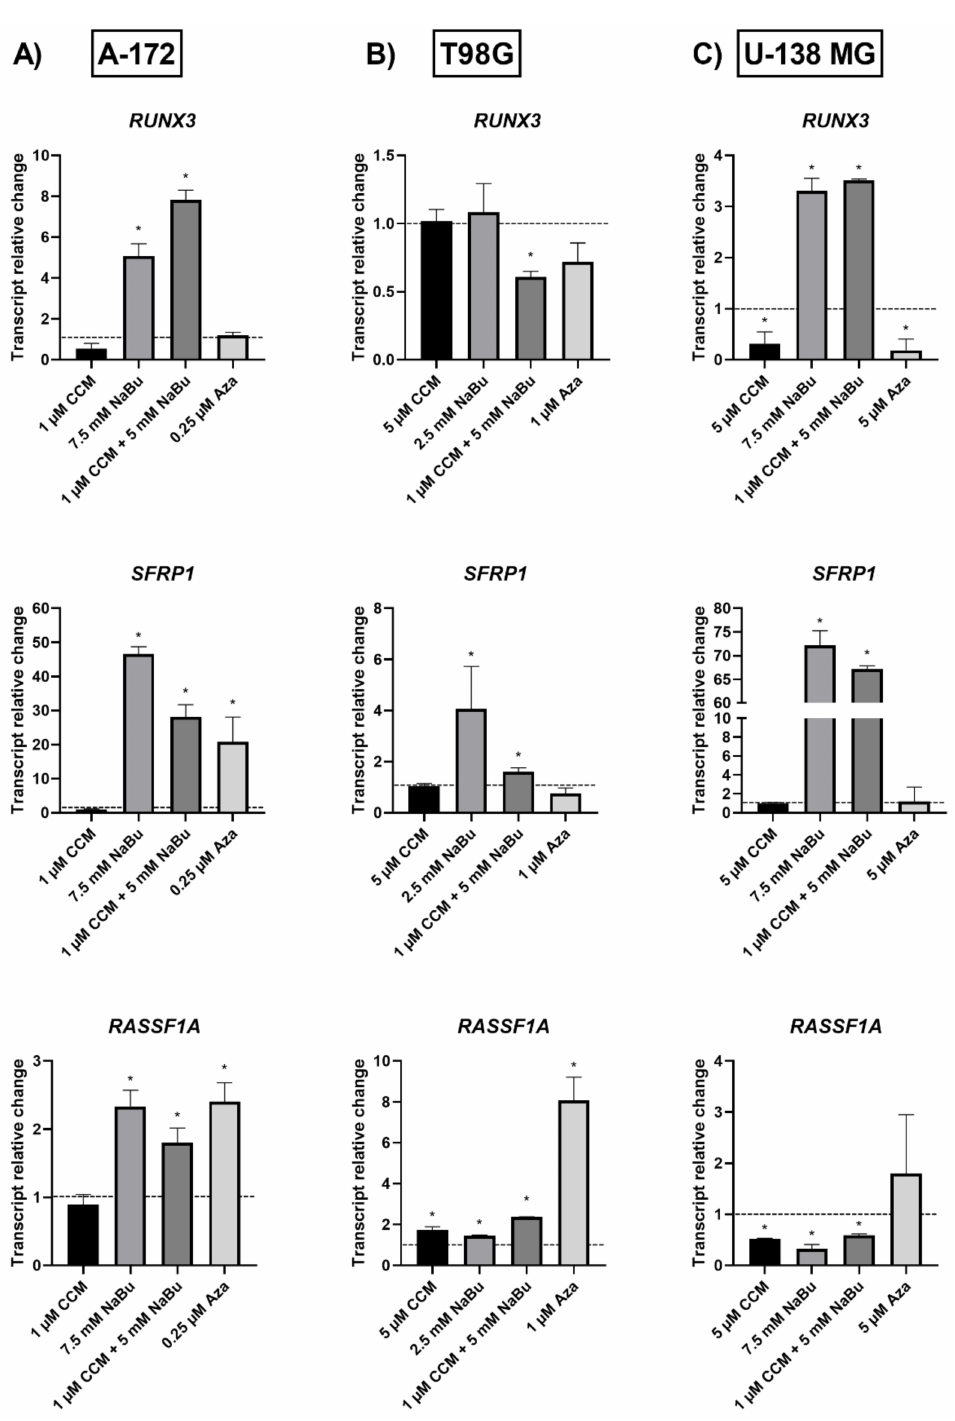
Figure 7. Transcript relative change of Wnt pathway antagonists, RUNX3 , SFRP1 , and cell cycle regulator, RASSF1A in A-172 ( A ), T98G ( B ), and U-138 MG ( C ) cells after treatment with CCM, NaBu, combination treatment of CCM & NaBu, and Aza. Data are presented as mean values ± SEM from two independent experiments. Control equals 1 and is indicated with a horizontal line. (*) above bar indicates statistically significant differences from control group, p <